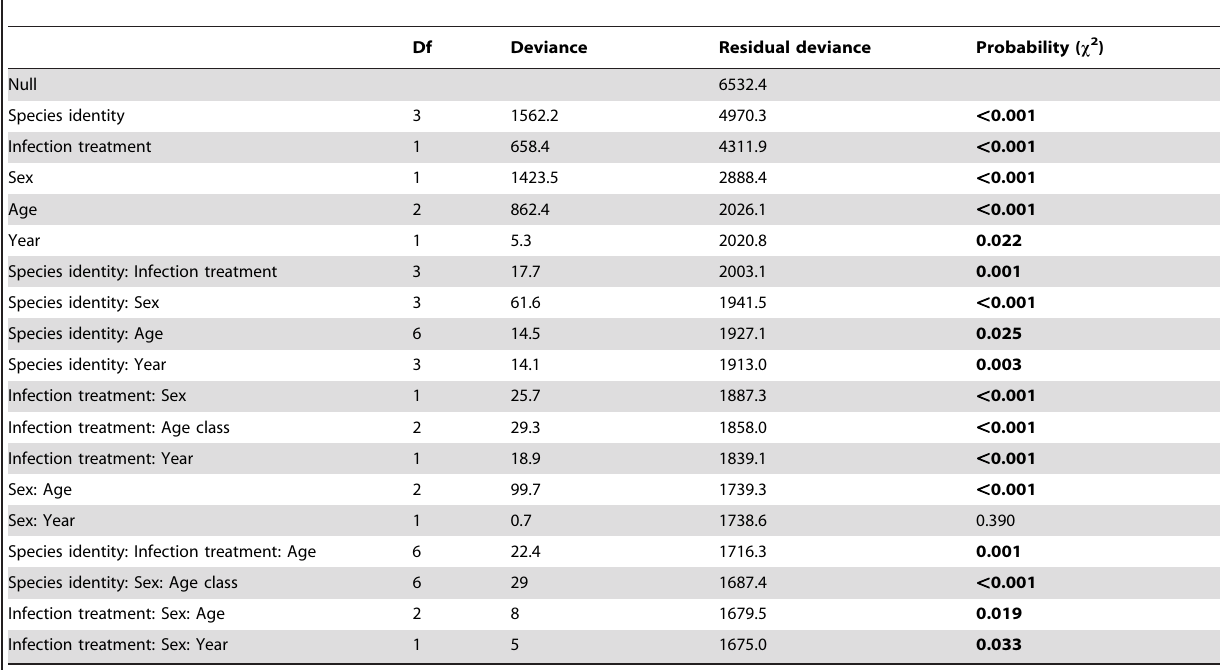
Table 3. Analysis of deviance for expected gregarine abundance for the experimental study, according to species identity, experimental infection treatment (parasite-treated and parasite-control), sex, age and year and their interactions.